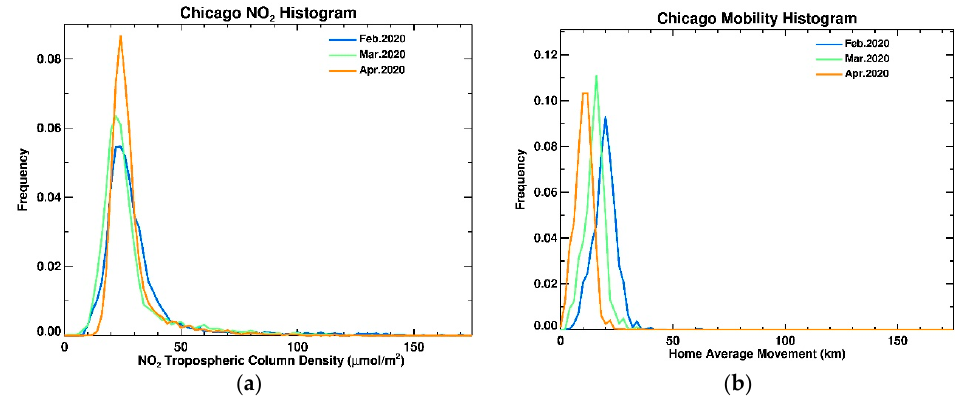
Figure 13. Distribution of NO 2 concentration in Chicago in February ( a ), March ( b ) and April ( c ). While there was a similar trend in decreased mobility with Los Angeles, the spread of the total column of NO 2 was much narrower in Chicago (Figure 14). This is partially due to the fact that the area observed was much smaller than the Los Angeles basin. The other notable difference was that that the average distance for commuting was much shorter for Chicago than Los Angeles.